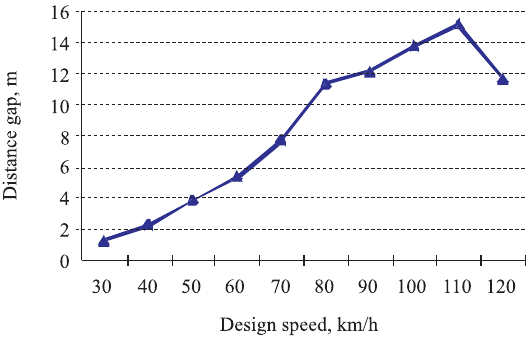
Fig. 5. Distance gap between the two braking